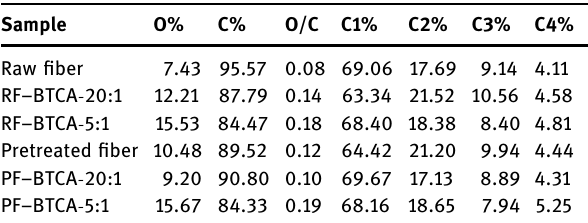
Table 2: Atomic percentages; O/C ratio; and C1, C2, C3, and C4 distribution of CP fi bers